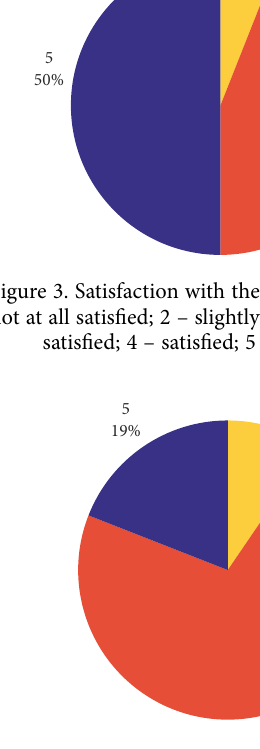
Figure 4. Satisfaction with the delivery frequency in Bristol: Figure 5. Satisfaction with the delivery safety in